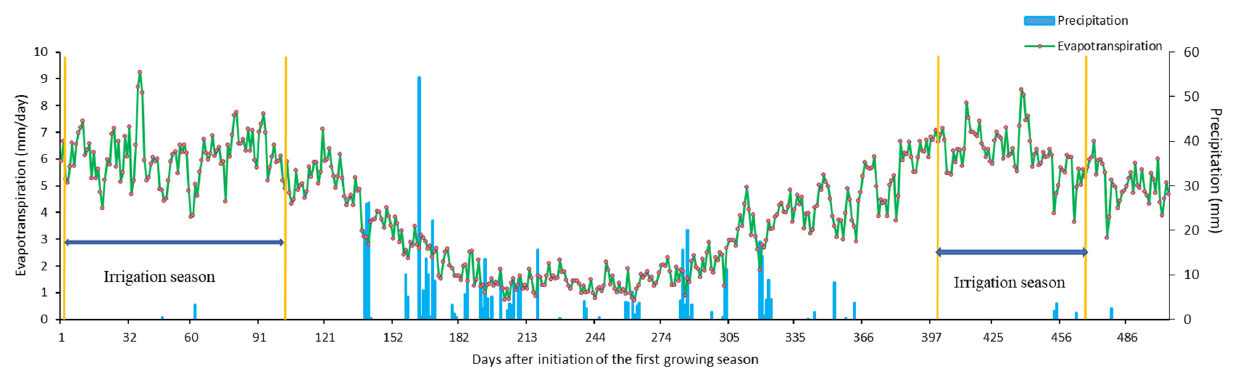
Figure 1. The daily crop evapotranspiration and the precipitations during the experiments starting